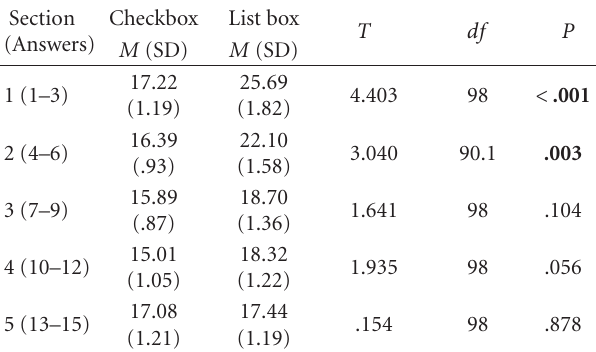
Table 2: Mean response time (s) for each